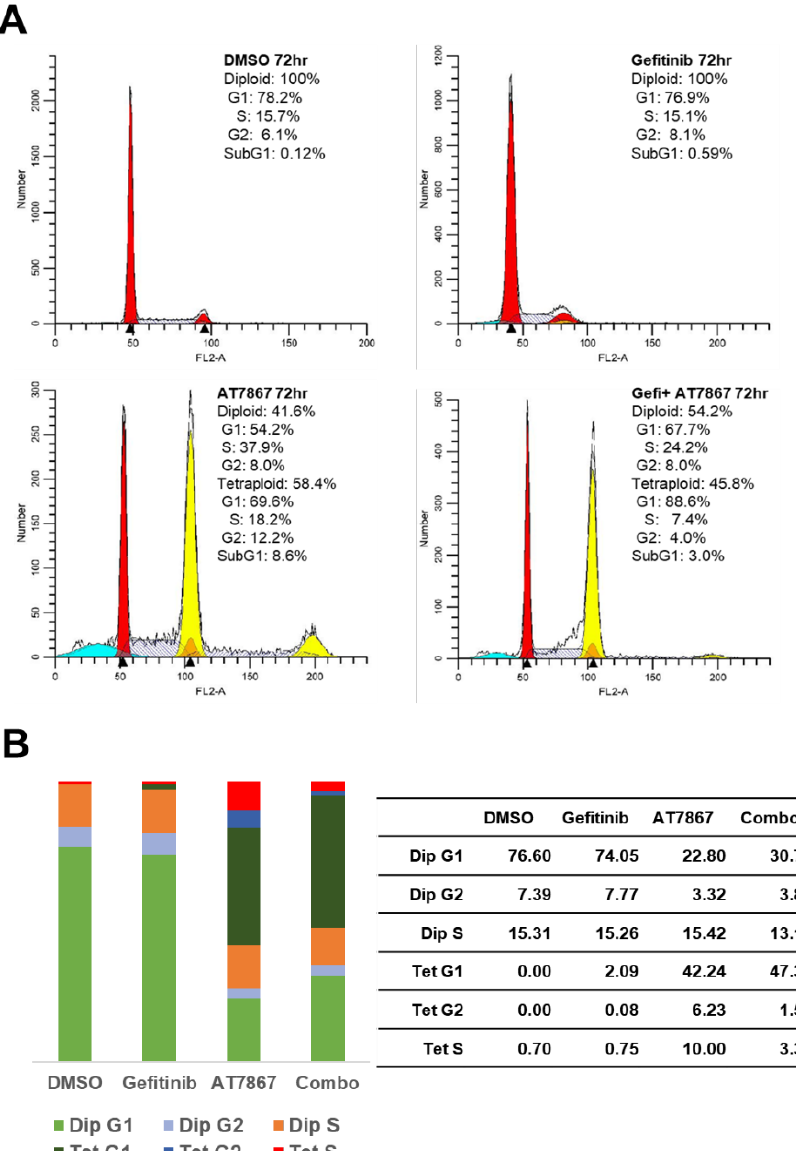
Figure 2. A combination of AT7867 and gefitinib-induced tetraploid gap 1 (G1) arrest in MDA-MB-231 cells. ( A ) Representative histograms of cell cycle analysis in MDA-MB-231 cells in the presence of each drug or gefitinib and AT7867 (Gefi+AT7867). ( B ) Relative distribution of cell cycle phases.